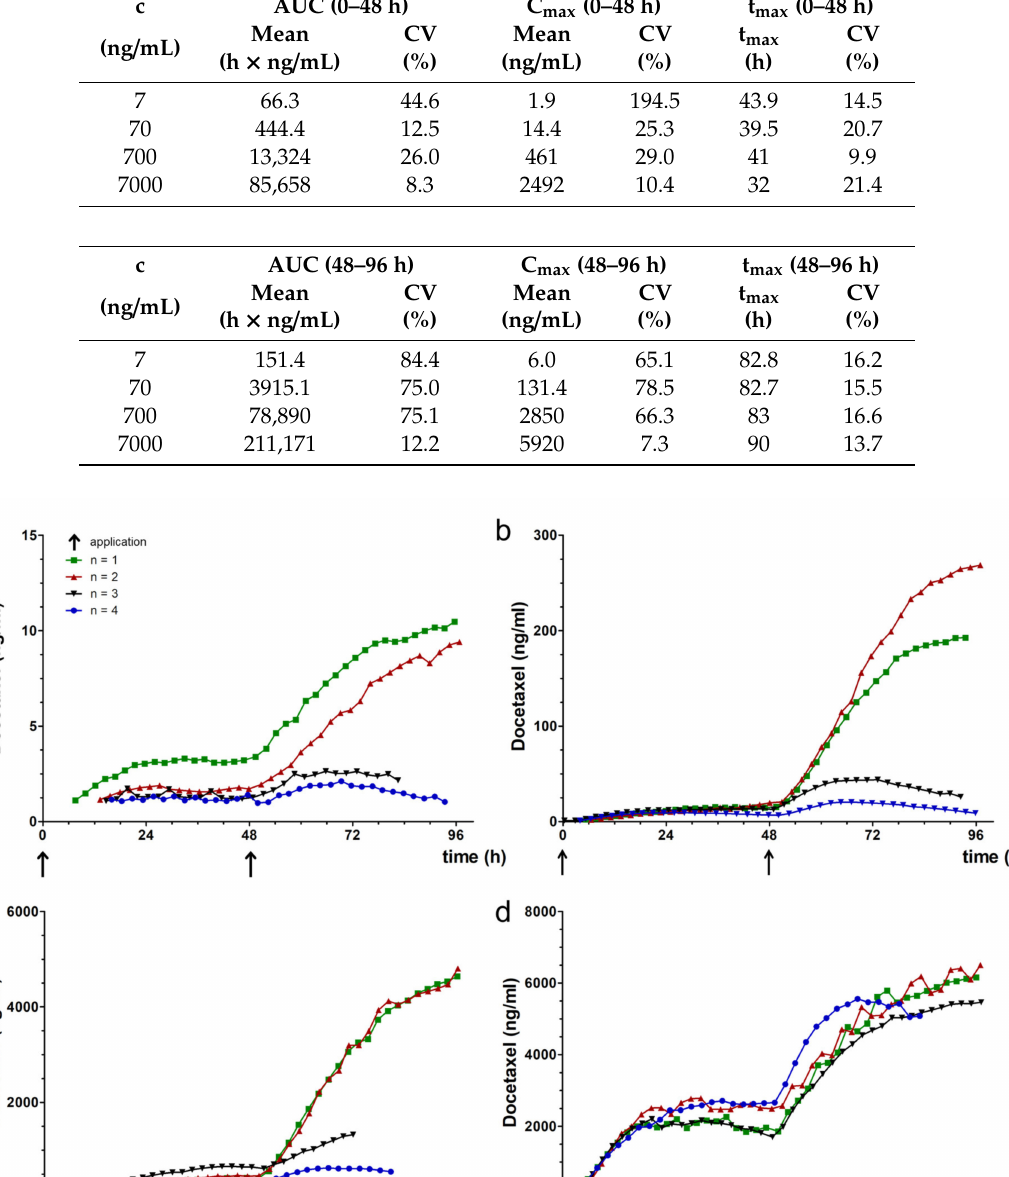
Table 4. Main pharmacokinetic parameters following 1st docetaxel application (0–48 h) and 2nd docetaxel application (48–96 h). c: docetaxel concentration, AUC: area under the curve.